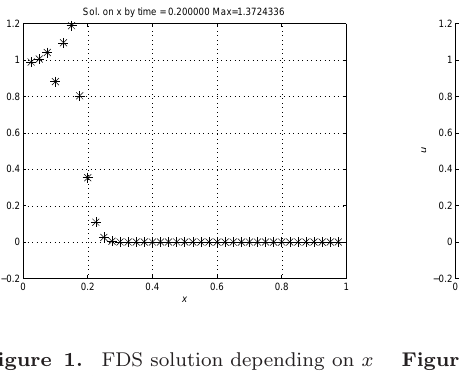
Figure 1. FDS solution depending on x for N = 40, t = 0 . 2.